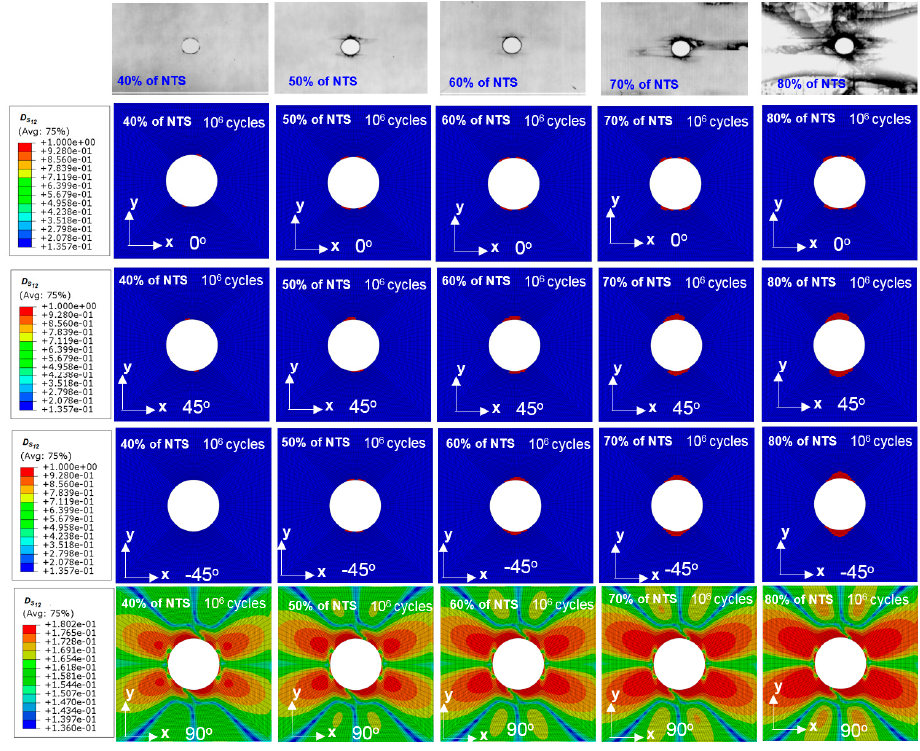
Figure 16. Reduction in strength Y T in each ply of the OHT specimen after 10 6 cycles.